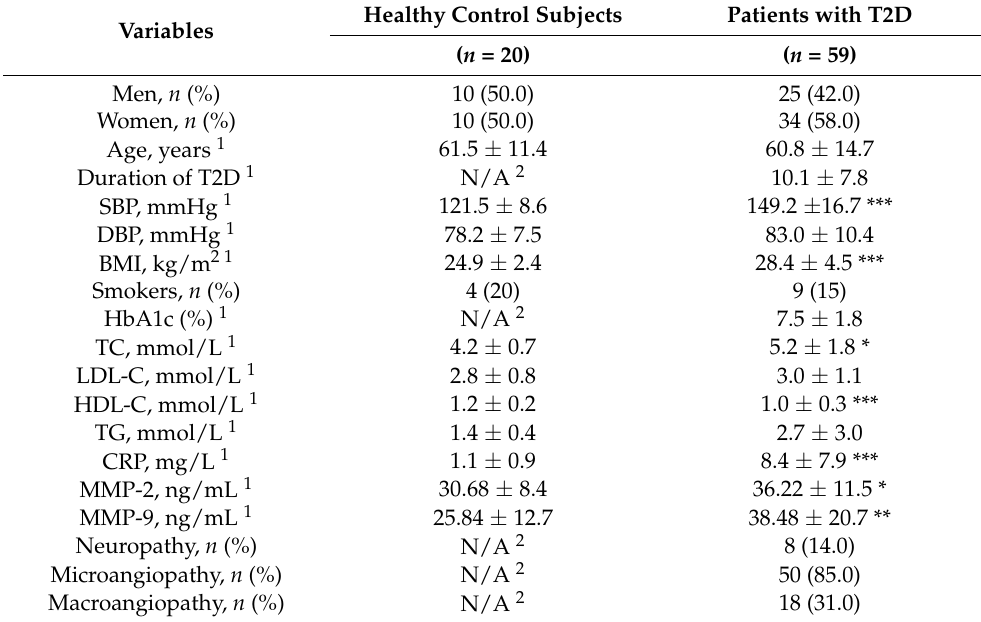
Table 1. Clinical characteristics of the groups in the study